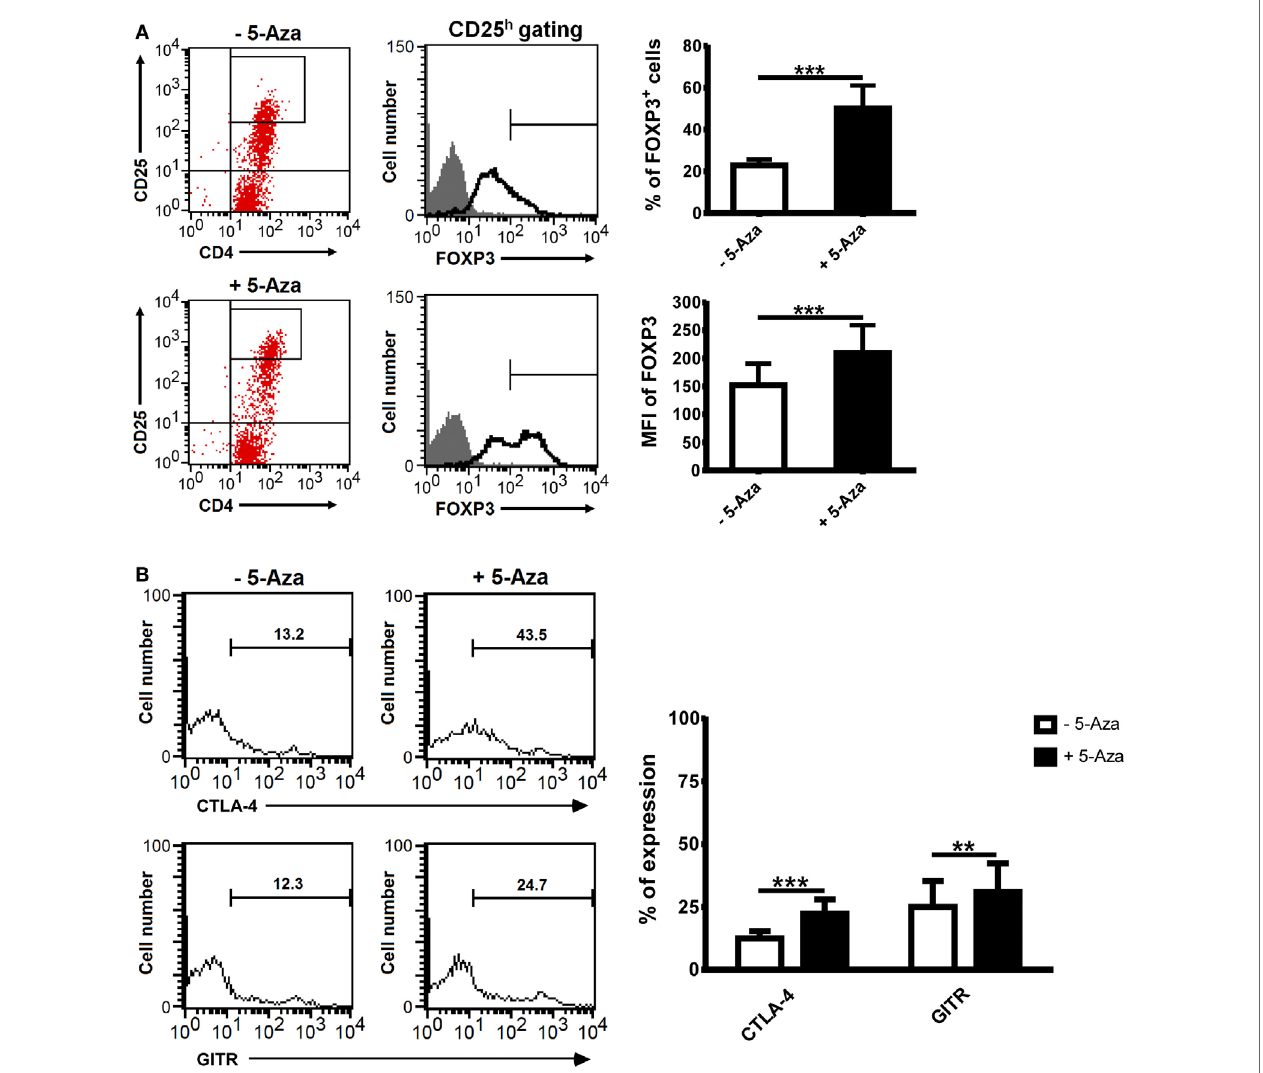
FigUre 1 | The treatment of 5-aza enhanced the expression of Treg-related markers . CD4 + CD25 − T cells were activated with anti-CD2/CD3/CD28 antibody-coated beads at a bead-to-cell ratio of 1:8 in the presence or absence of 5-Aza for 4 days. (a,B) CD25 highly expressing cells were gated to examine the level of FOXP3, CTLA-4, and GITR expression by FACSCalibur. Considering high level of non-specific staining of FOXP3 antibody PCH101, FOXP3 dim cells were excluded. One representative sample of nine experiments is shown. The results are shown as mean ± SD (* P < 0.05; ** P < 0.01; *** P <